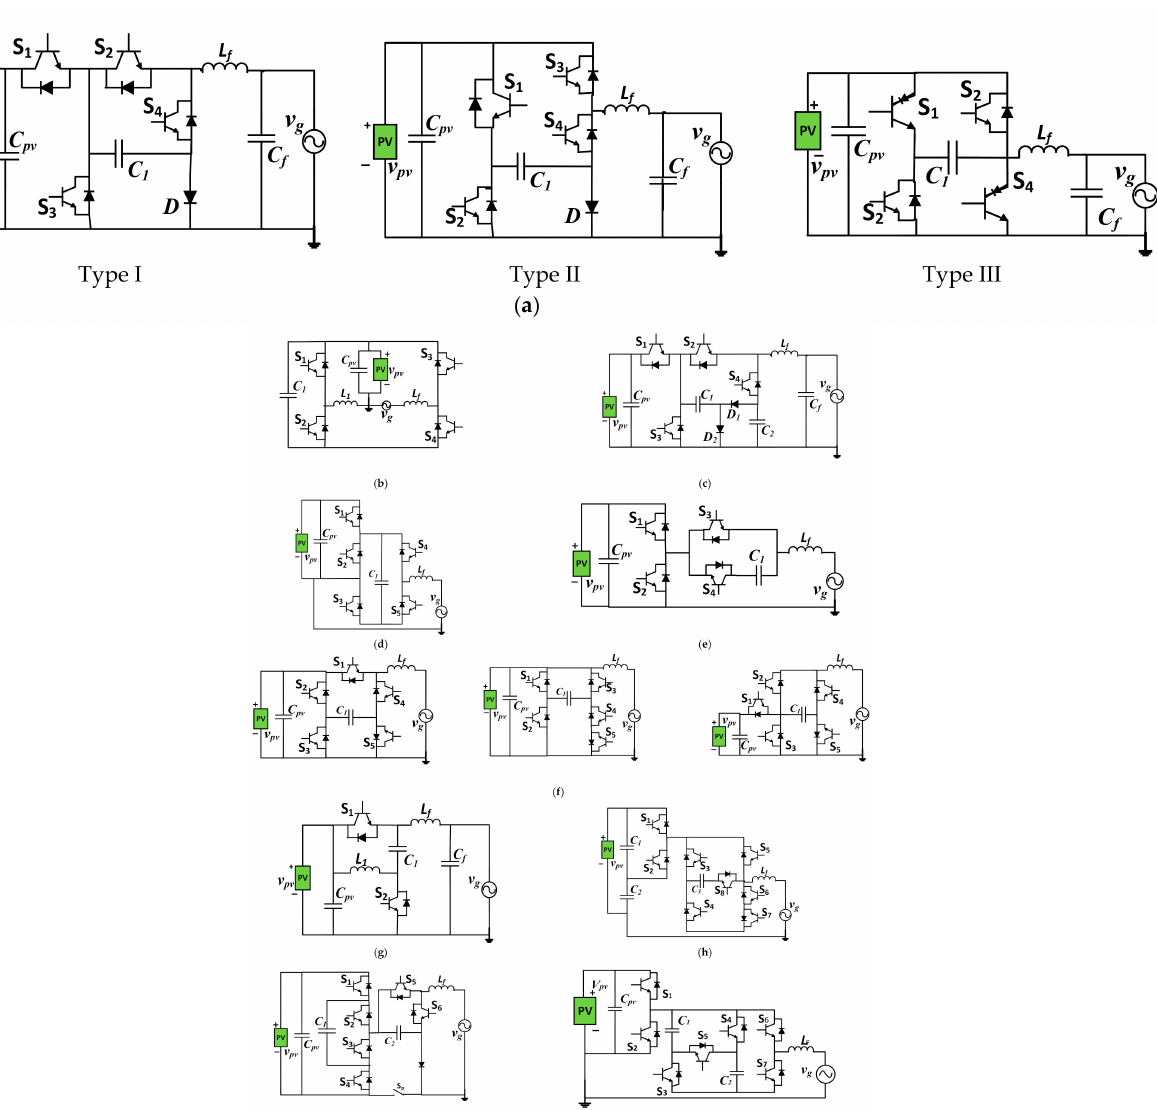
Figure 4. Voltage-source common-grounded (CSCG) converters (bucking type). ( a ) Converter presented in the work of [42–44], ( b ) converter presented in the work of [45], ( c ) converter presented in the work of [46], ( d ) converter presented in the work of [47], ( e ) converter presented in the work of [48], ( f ) converter presented in the work of [49], ( g ) converter presented in the work of [50], ( h ) converter presented in the work of [51], ( i ) converter presented in the work of [52], ( j ) converter presented in the work of